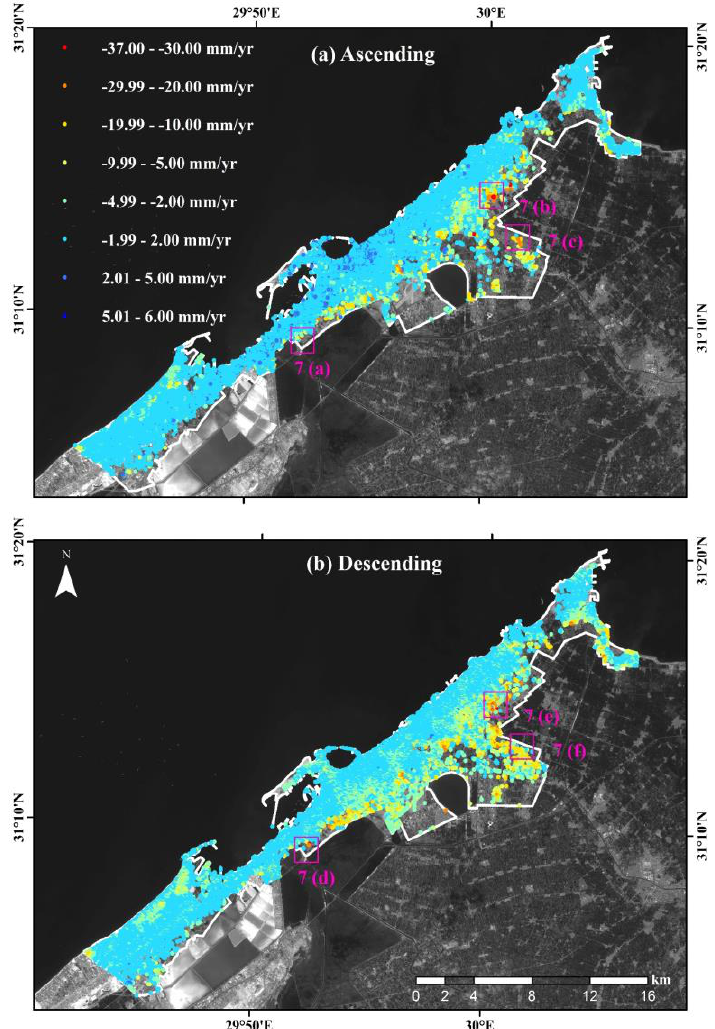
Figure 6. Displacement in the line of sight (LOS) presented on the Sentinel-2 gray image of 24 October 2018 blue band; ( a ) velocity in the LOS of ascending geometry and ( b ) is motion in the LOS of descending geometry.